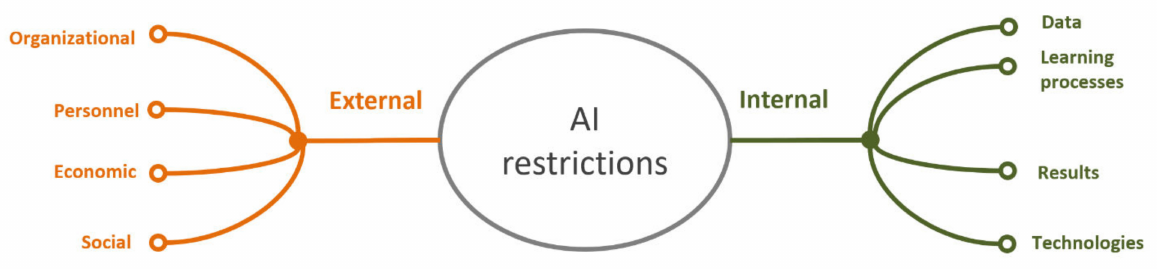
Figure 9. Constraints hindering the implementation of AI technologies in the economy. Source: generated by the